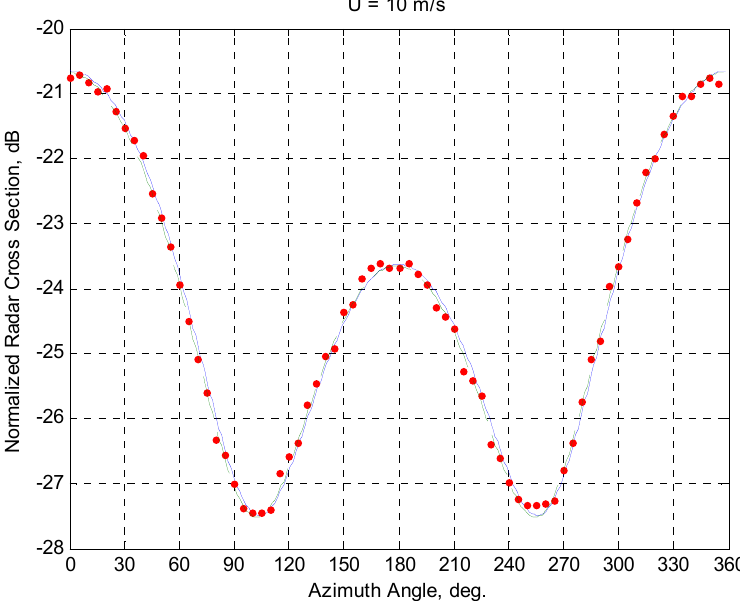
Figure 2. Azimuth NRCS curve using Equation (1) at the incidence angle of 45°, “true” wind speed of 10 m/s and “true” up-wind direction of 0° (solid line); generated “measured” NRCS after the averaging of 1565 samples in a five-degree azimuth sector (red dots); and azimuth NRCS curve using Equation (1) corresponding to “measured” wind speed of 9.9718 m/s and up-wind direction of 358.7° retrieved from the azimuth sector of [ − 90°, 90°] (dashed line).